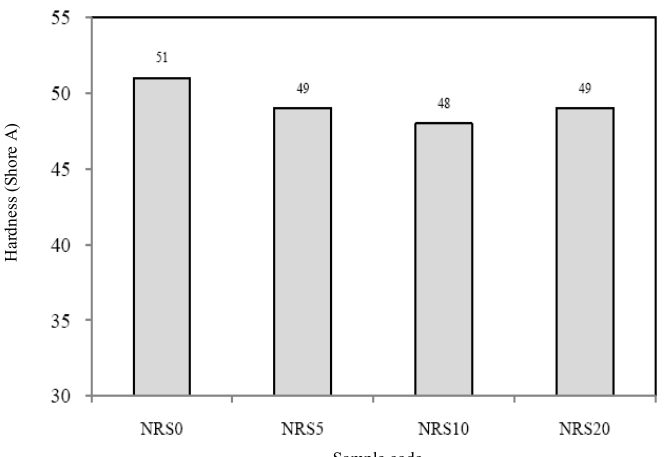
Figure 9 . Hardness of samples at various silica ratios.